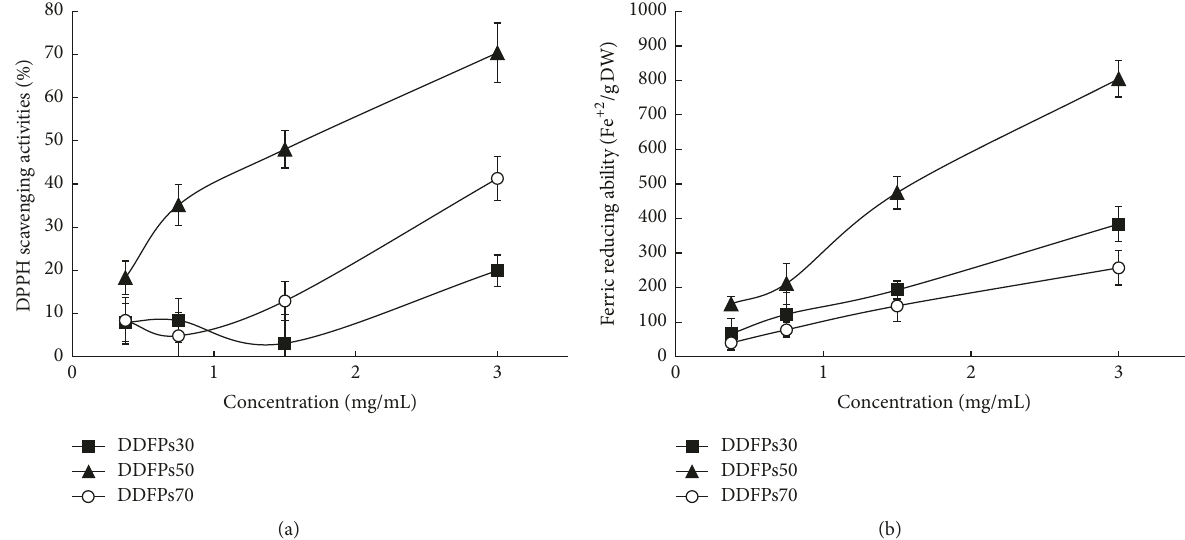
Figure 3: Antioxidant activity of three fractions from DDFPs. (a) Scavenging effect on DPPH radicals. (b) Reducing power evaluation.